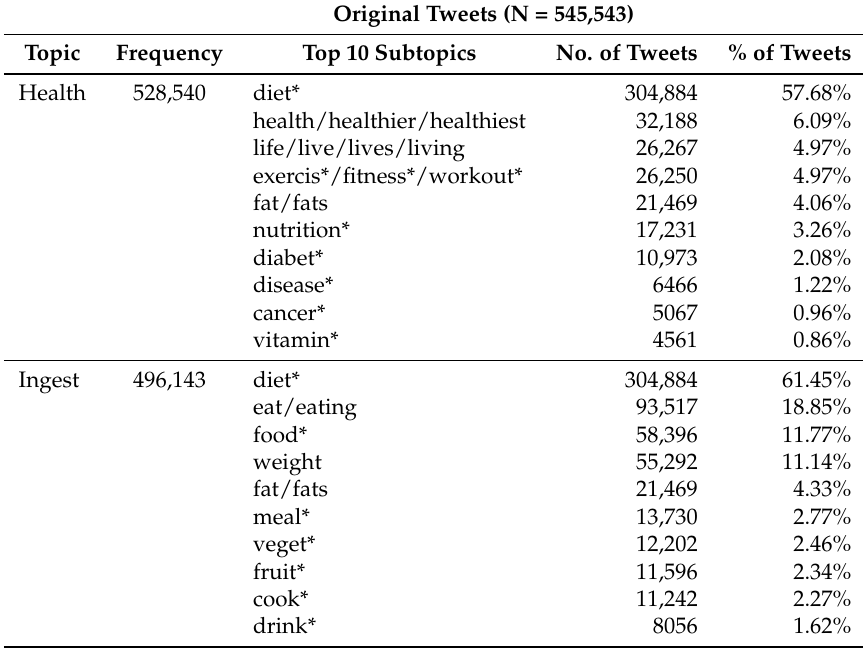
Table 6. Topic and Sub-topic Summary—Original Tweets.